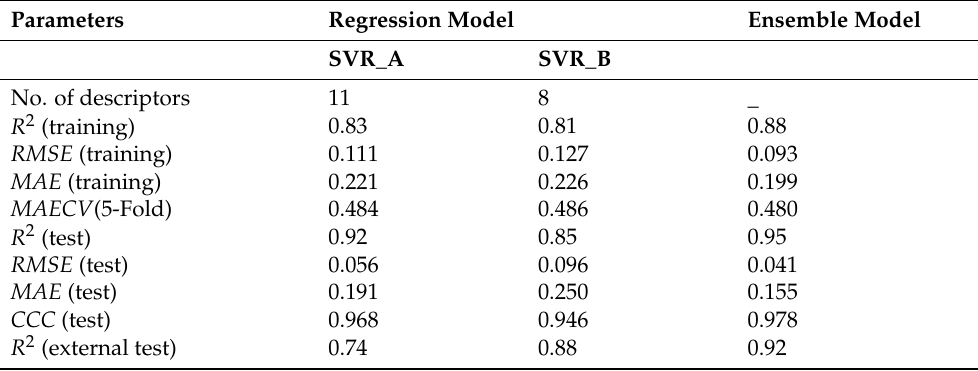
Table 2. Statistical parameters of SVR_A and SVR_B models.